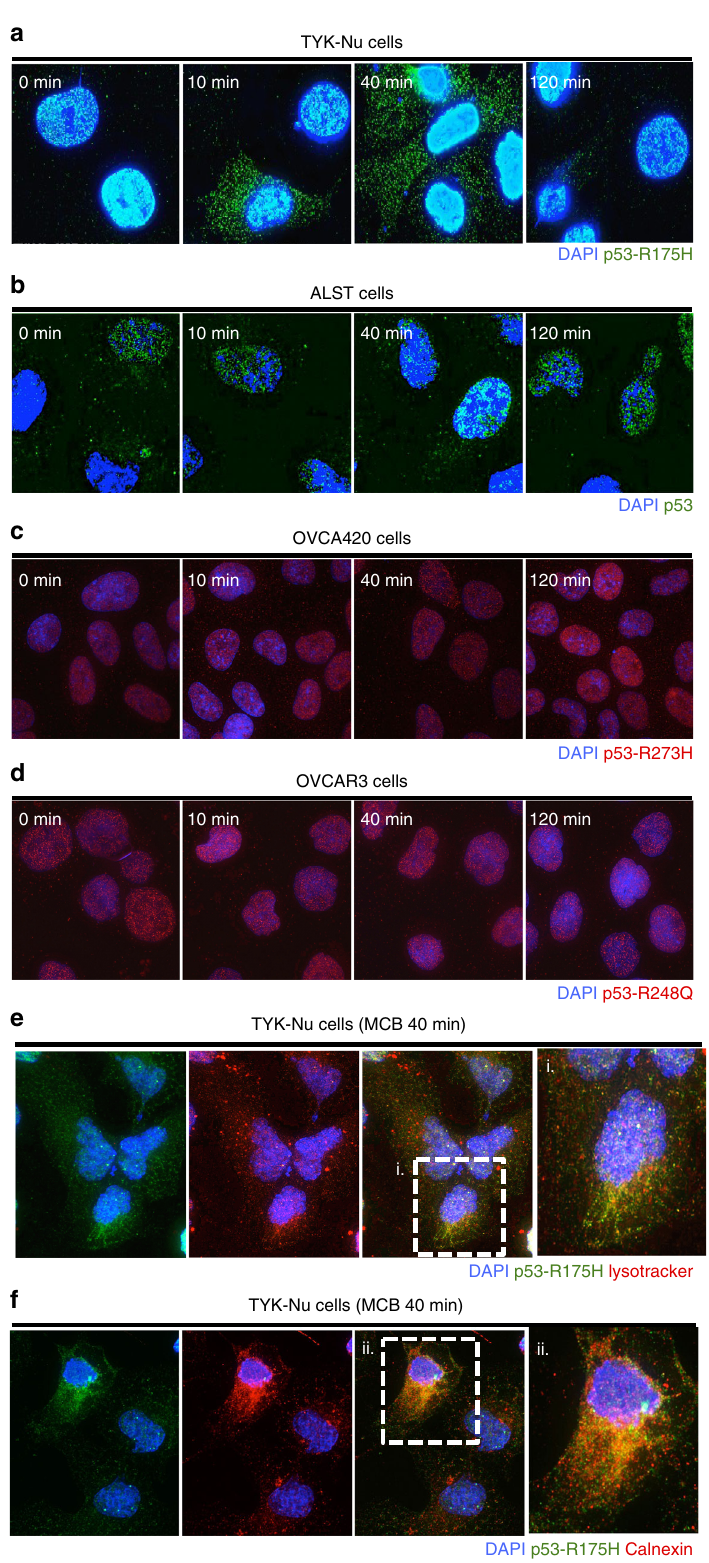
Fig. 3 MCB-613 causes nuclear export of p53-R175H protein. a – d MCB-613 caused a rapid export of p53-R175H (TYK-Nu cells) protein but not b p53-WT (ALST cells) or other GOF mutp53 c p53-R273H (OVCA420 cells), and d p53-R248Q (OVCAR3 cells). e , f Upon MCB-613 treatment, p53-R175H (green) co-localizes with e lysosomes (red; lysotracker) and f endoplasmic reticulum (red; α -calnexin) in TYK-Nu